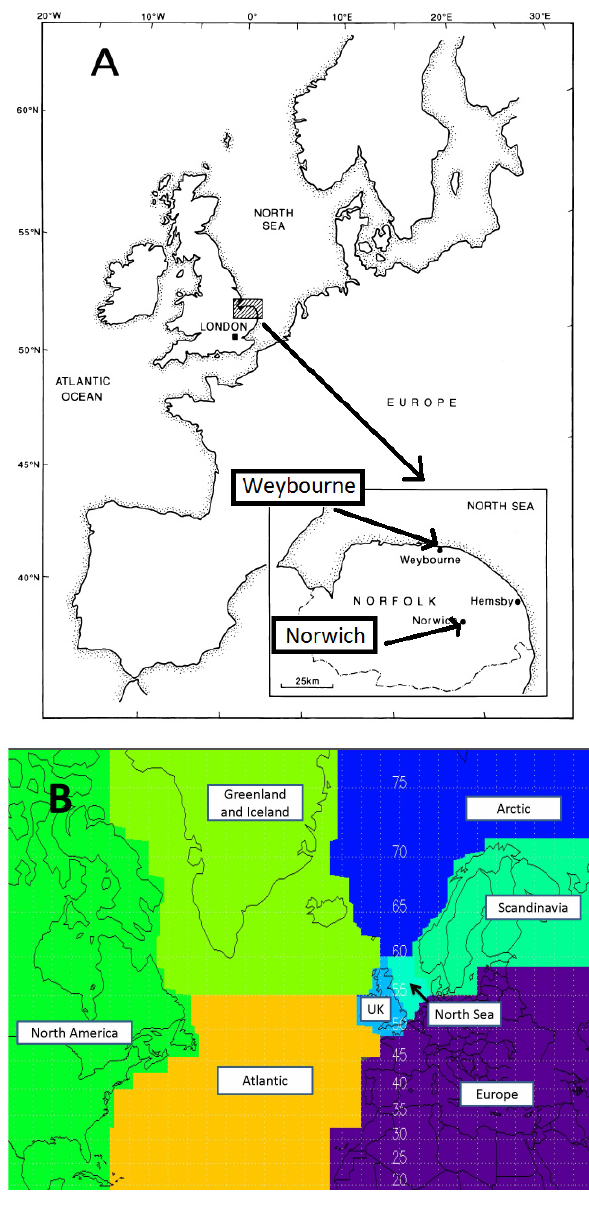
Fig. 1. (a) The location of Weybourne Atmospheric Observatory; (b) the categories of air masses according to the regions within the domain of passage for 3 day footprints in the NAME